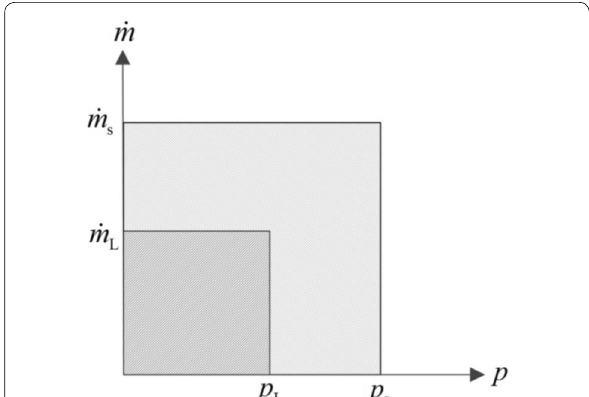
Figure 7 Power source characteristic curve